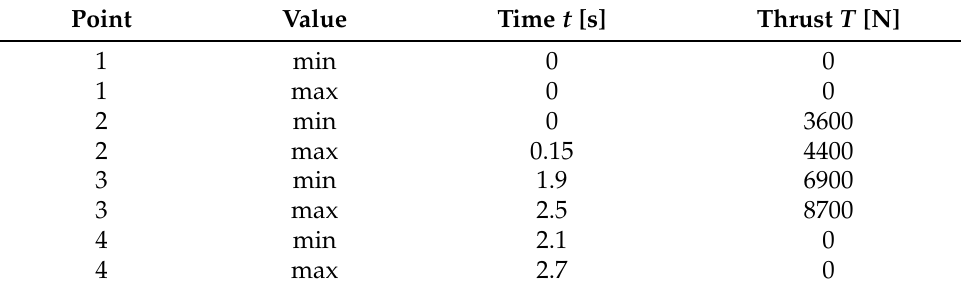
Table 3. Thrust curve uncertainties.